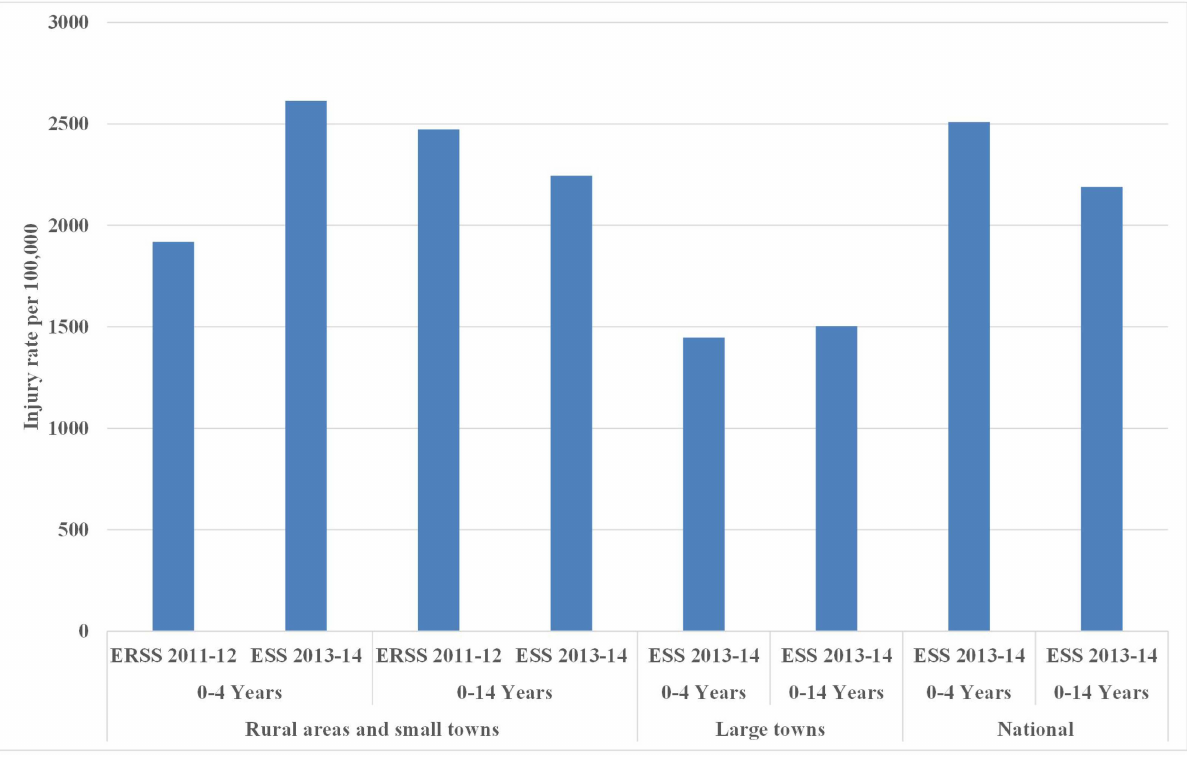
than fatal injuries and may lead to long-term disability and other health issues. As a result, ignoring non-fatal injuries creates a serious underestimation of the burden of injuries. Fig 5 shows that between the two waves, the annual incidence rate of child injuries increased from 1,918 (95% confidence interval (CI): 860–4,270) to 2,614 (95% CI: 1,113– 6,118) per 100,000 for children under-5 years in rural areas and small towns. Large towns were covered in wave 2, but not wave 1, making it infeasible to estimate the national trend. Based on ESS data only, disparities in annual incidence rates of injuries between children living in rural, small town, and large town households were statistically significant. Incidence per 100,000 children under 5 years was higher in rural areas and small towns than in large towns (1,447, 95% CI: 156–13,219). Similar disparity was found among children aged 0–14